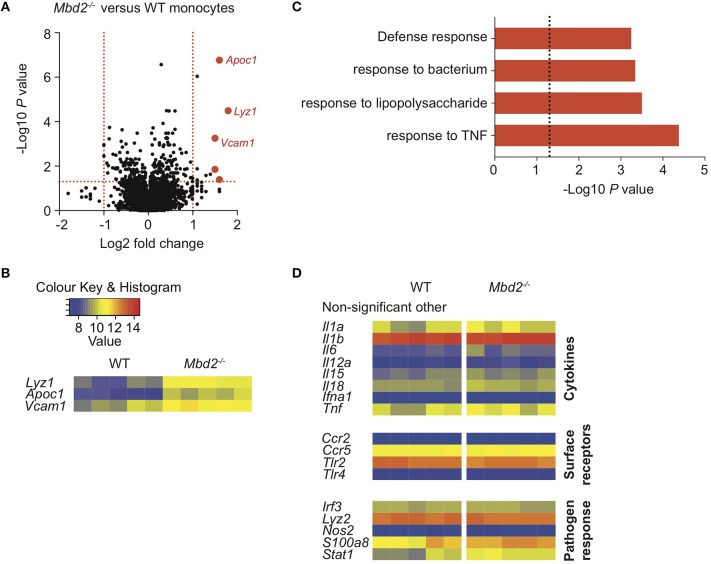
The impact of Mbd2 deficiency on mRNA expression by colon monocytes during colitis. Monocytes (CD11b+Ly6C+F4/80−MHC-II−/+) were isolated and purified via FACS from the colon lamina propria of Mbd2−/− or WT littermate co-housed mice after 6 consecutive days of DSS treatment. RNA was extracted for microarray mRNA expression analysis (5 biological replicates per genotype). (A) Volcano plot depicts differential gene expression profile of Mbd2−/− vs. WT monocytes, with selected genes highlighted in red. Dashed lines represent P < 0.05, and ± 1-fold change. (B) Heat map of relative expression values for the highlighted loci in (A) (log2 normalized intensity, one-fold change-filtered, P < 0.05). (C) Selected pathways from GOterm analysis of significantly altered mRNA transcripts (P < 0.05) from (A), dashed line represents P < 0.05. (D) selected other non-significant loci based on literature review of monocyte-associated inflammatory processes.